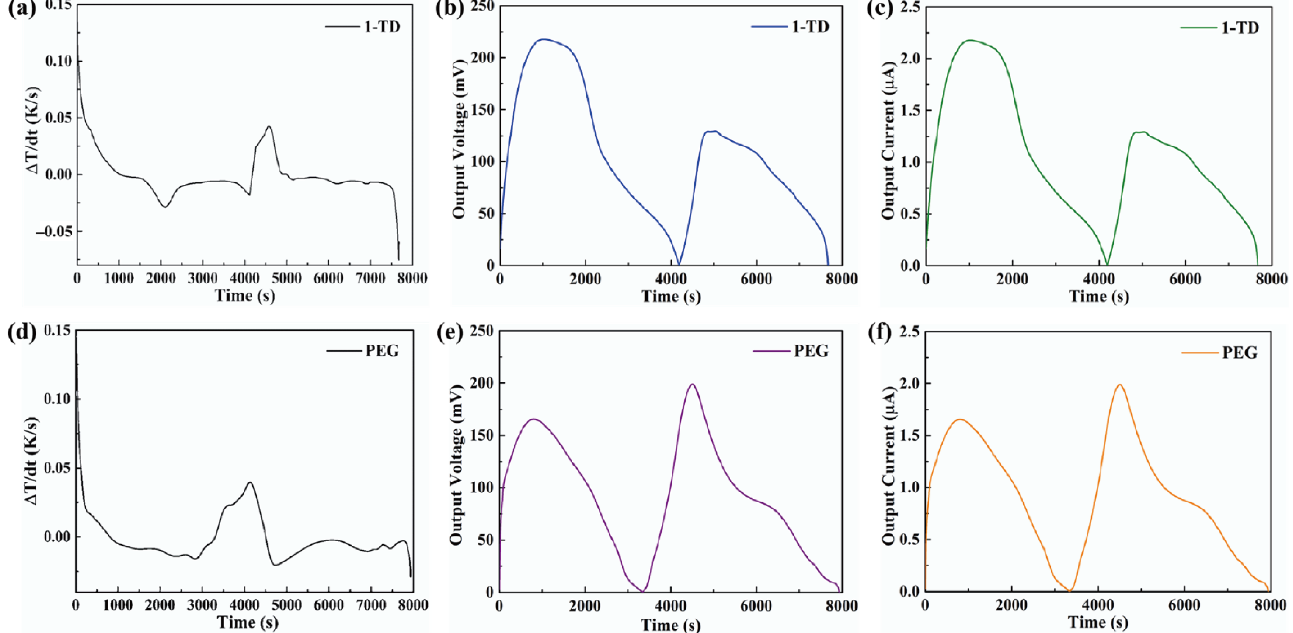
Figure 9. ( a ) Change of temperature difference by using the 1-TD composite under 10 mW/cm 2 , ( b ) output electrical voltage peak, and ( c ) output electrical current peak under 10 mW/cm 2 . Solar light intensity of 15 mW/cm 2 . ( d ) Change of temperature difference by using PEG composite, ( e ) output electrical voltage peak, and ( f ) output electrical current peak.